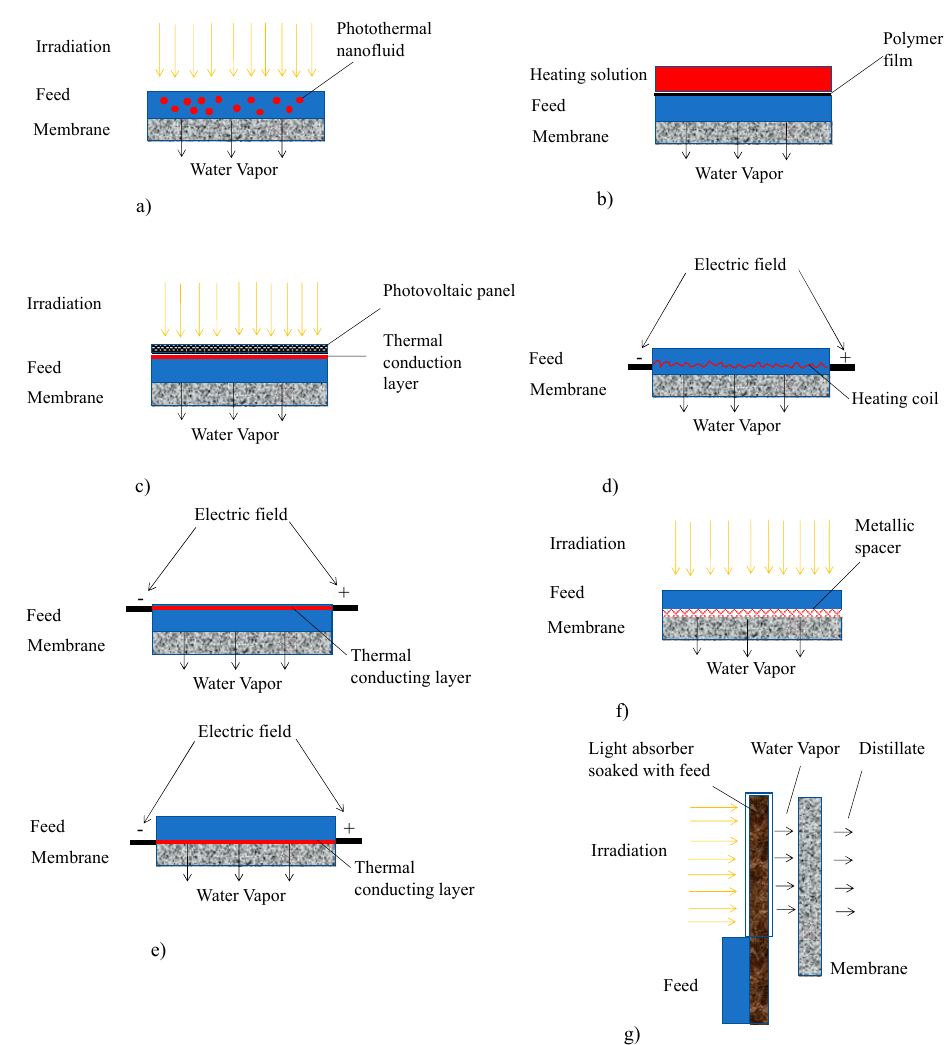
Figure 4. Investigated approaches for heating the feed inside the module through the use of ( a ) photothermal nanofluids, ( b ) a heating solution, ( c ) solar cells, ( d ) heating coils, ( e ) thermal conducting layers, ( f ) metallic spacers and ( g ) light absorbers.